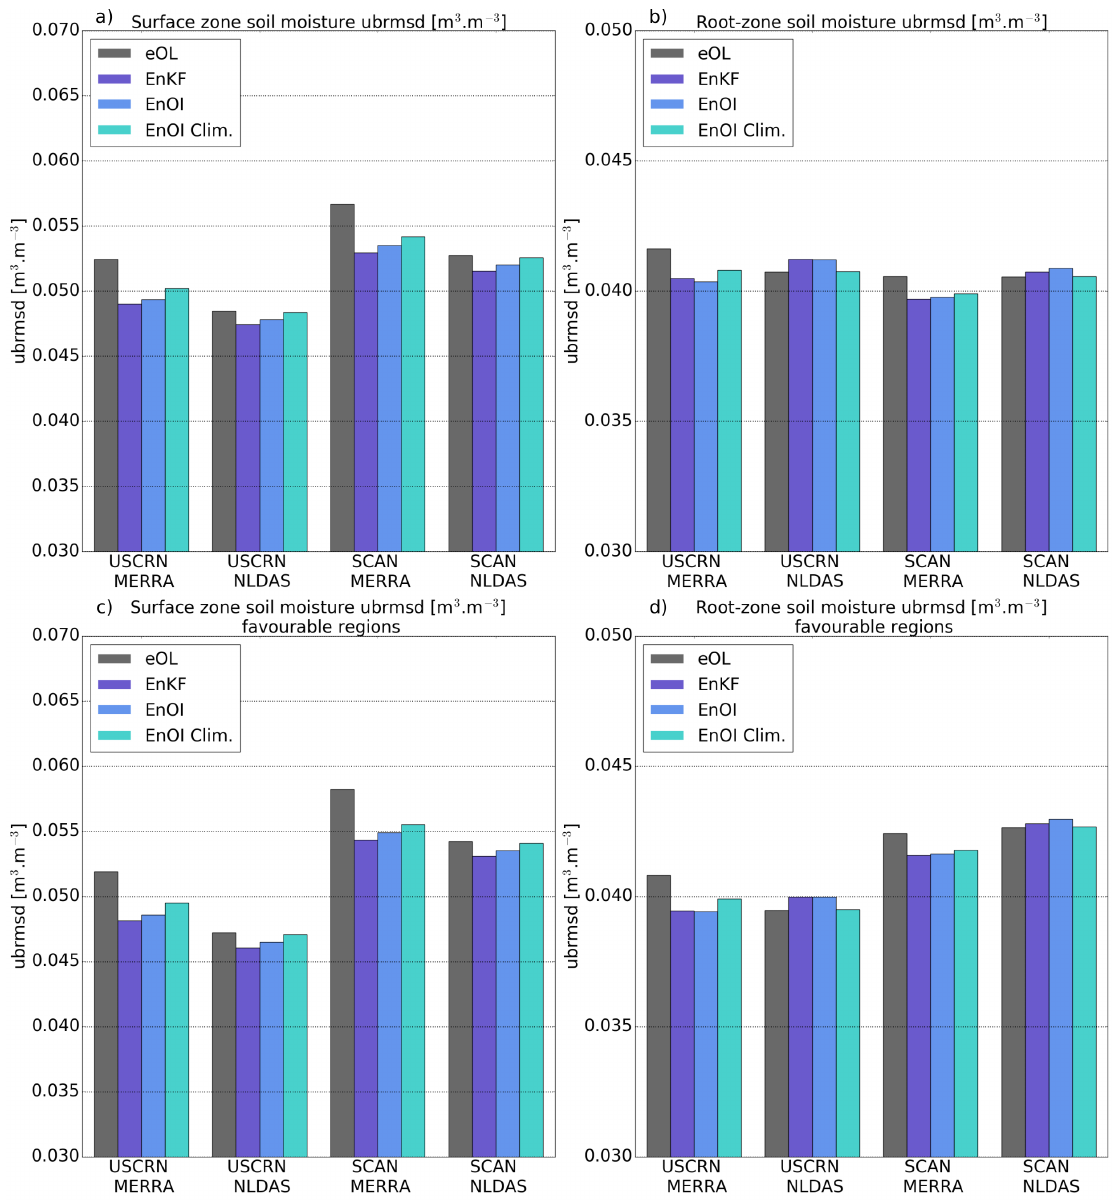
Figure 10. Summary statistics for the unbiased root mean square difference (ubrmsd, m 3 m − 3 ) between the model and in situ data, computed for all stations ( a , b ) and favourable regions ( c , d ). ( a ) domain average surface zone ubrmsd, eOL (black), EnKF (dark blue), EnOI (light blue) and EnOI-Clim (turquoise); ( b ) domain average root-zone